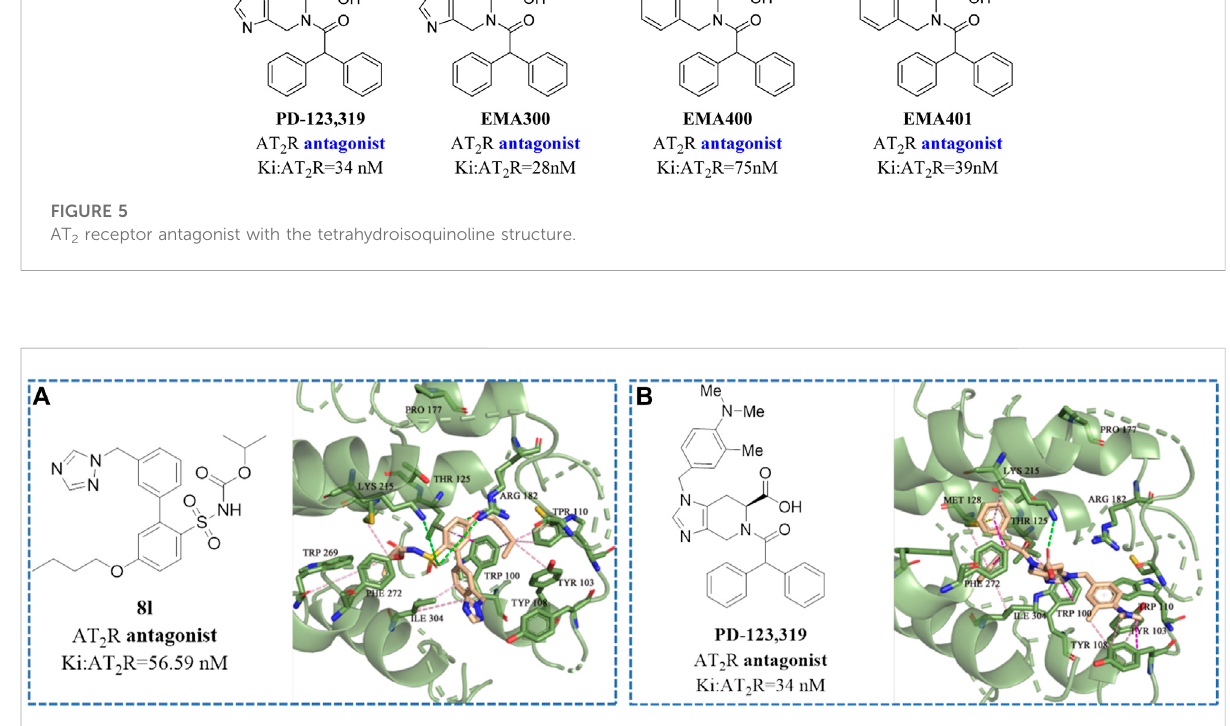
FIGURE 6 The structural formula and docking results of (A) compound 8l and (B) PD-123,319 (Blankley et al., 1991) ( Ki : AT 2 R = 34 nM). The green dotted line indicates hydrogen bond interaction. The purple dotted line indicates hydrophobic interaction.